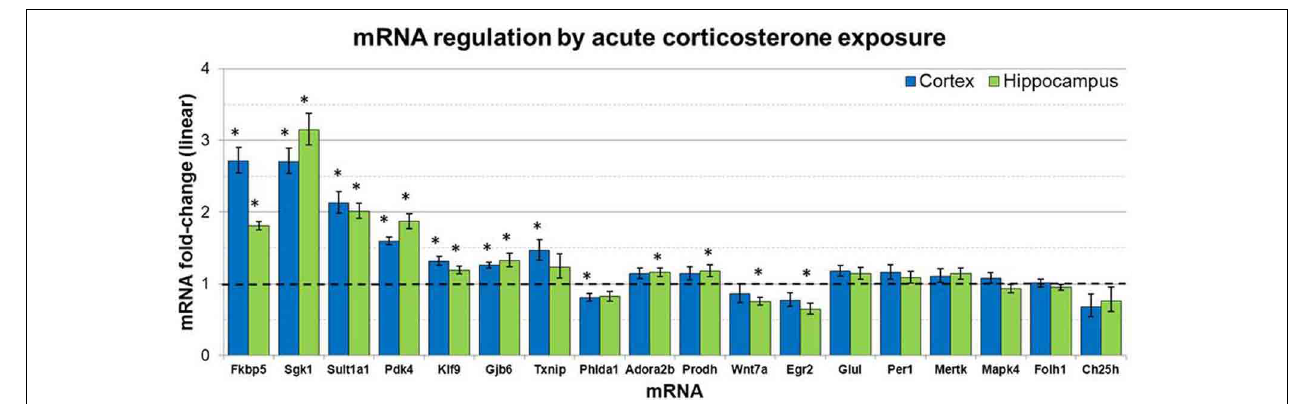
FIGURE 3 | Acute corticosterone exposure regulates select mRNAs in hippocampus and prefrontal cortex. Gene expression fold-change ratios for mRNAs regulated by glucocorticoids in astrocytes in vitro (Carter et al., 2012) in prefrontal cortex and